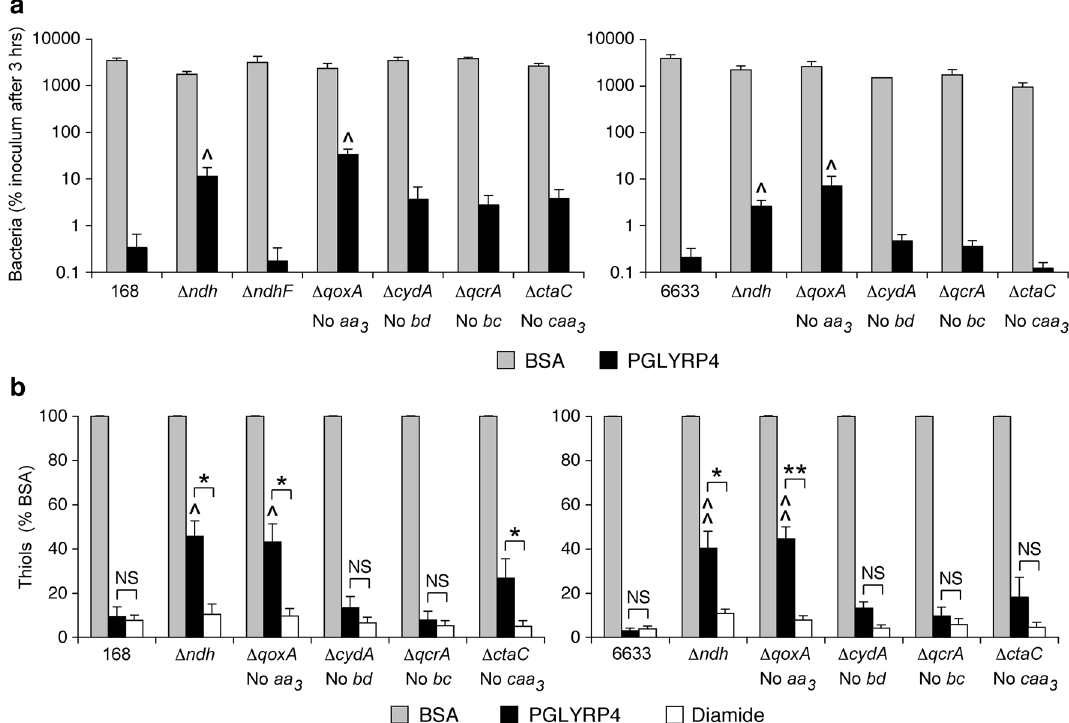
Figure 5. Deletion of genes for NDH (Δ ndh ) or cytochrome aa 3 -600 (Δ qoxA ) increases resistance of B. subtilis to PGLYRP4-induced killing and attenuates PGLYRP4-induced thiol depletion. The results are the numbers of bacteria (CFU) expressed as percent of initial inoculum (100%) ( a ) or the amounts of thiols expressed as percent of control with BSA (100%) ( b ) and are means ± SEM from 4 to 6 experiments (biological replicates); ^ P < 0.05, ^^ P < 0.001 mutant vs parental strain; NS not significant ( P > 0.05); * P < 0.05, ** P < 0.001 as indicated by